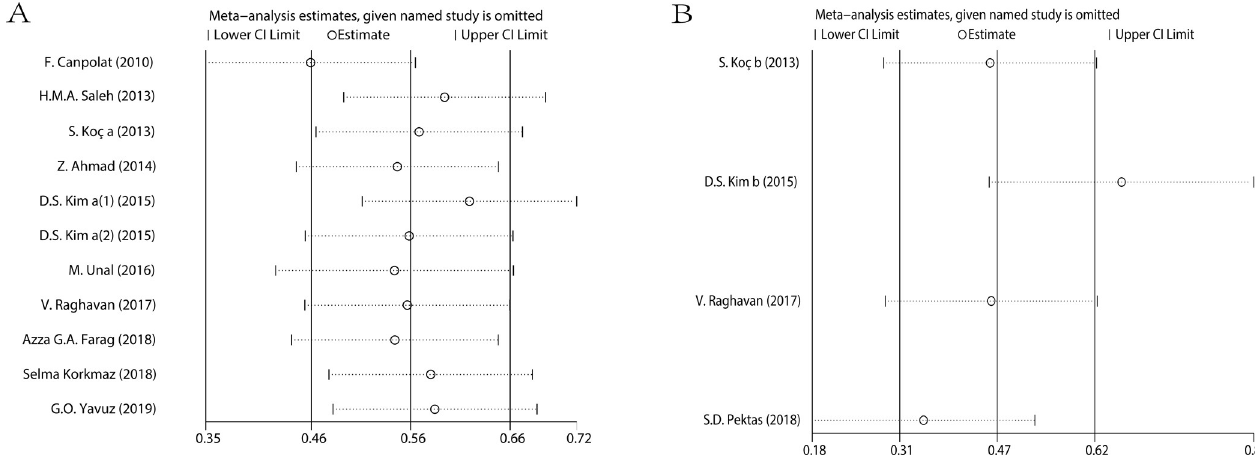
Fig 3. Sensitivity analysis of the association of MPV (A), RDW (B) and the presence of psoriasis.